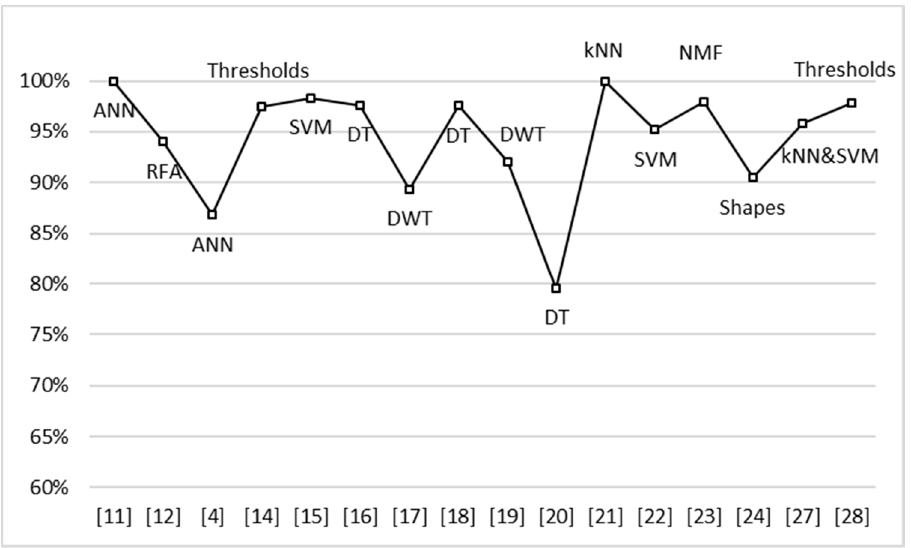
Figure 3. The accuracy of fall detection algorithm obtained from the twenty most cited papers since 2014.